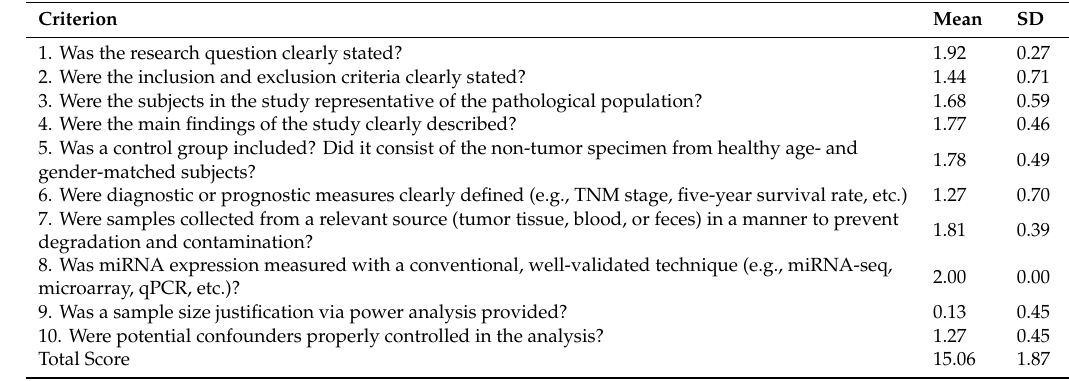
Table 3. Study quality